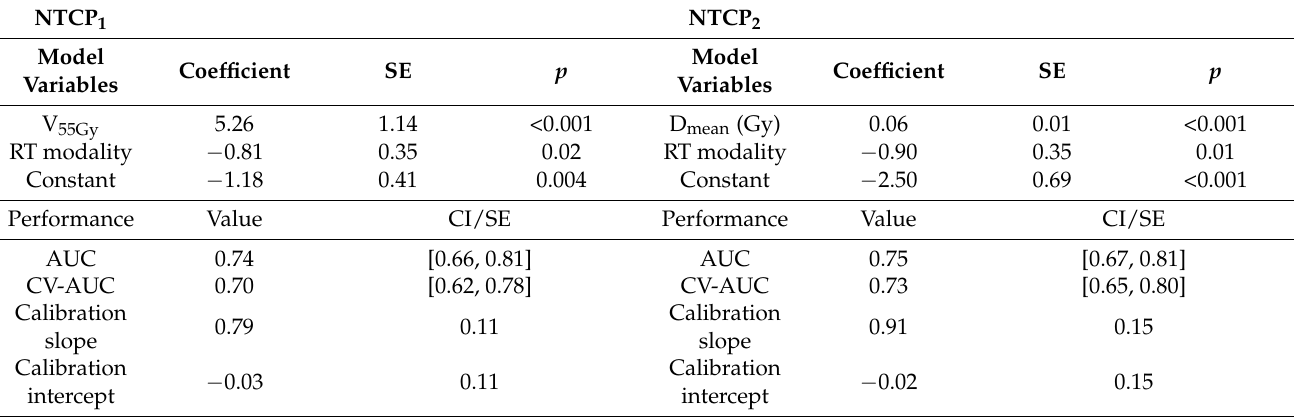
Table 2. Multivariable logistic regression model coefficients and model performance for radiation- induced esophagitis using the whole esophagus (NTCP 1 ) and the thoracic esophagus (NTCP 2 ).